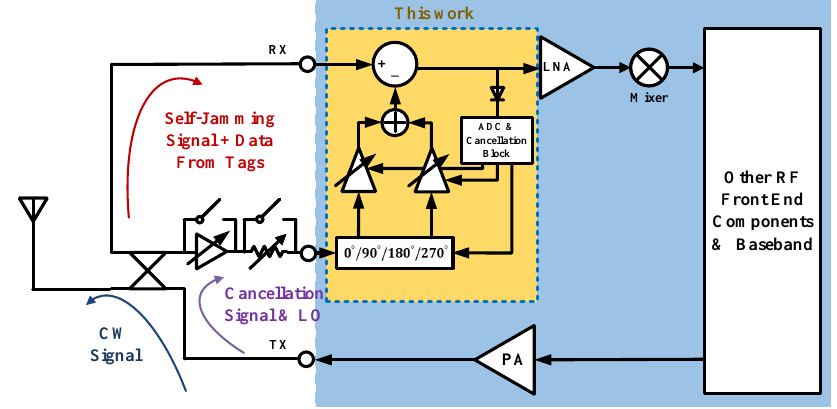
Figure 1. The architecture of the UHF RFID transceiver.